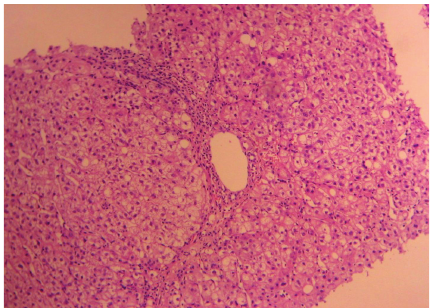
Figure 1: Histology: portal tract with mild lymphocytic inflamma- tory infiltrate with eosinophils and focal interface hepatitis (HE, 40x).